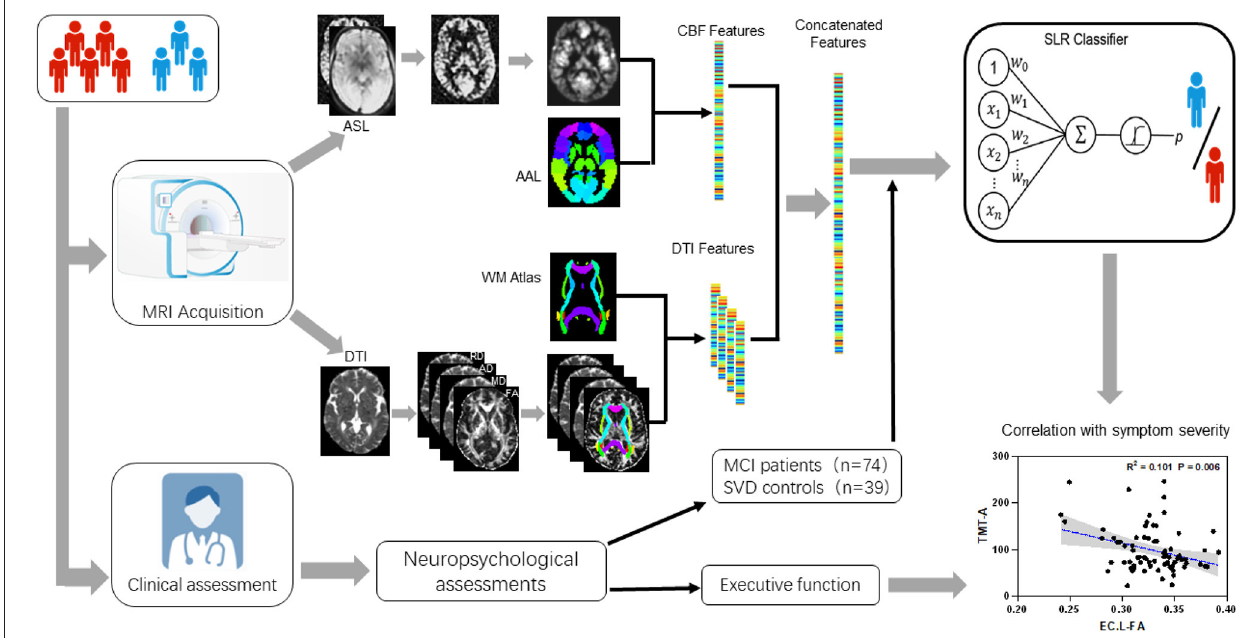
FIGURE 1 | Research flow chart including: MRI procedures from DTI and ASL data collecting to features extracting, multimode imaging features including mean FA/MD/AD/RD and CBF within multiple ROIs defined by widely used ICBM templates for white matter diffusion features and AAL templates for gray matter perfusion features; A comprehensive battery of neuropsychological tests including general cognitive function, attention-executive function, visuospatial function, language and working memory, functional ability; Three sets of sparse logistic regression (SLR) classifiers were trained using diffusion-based, perfusion-based, and diffusion-perfusion combined features; Correlation of the final selected features with executive function.